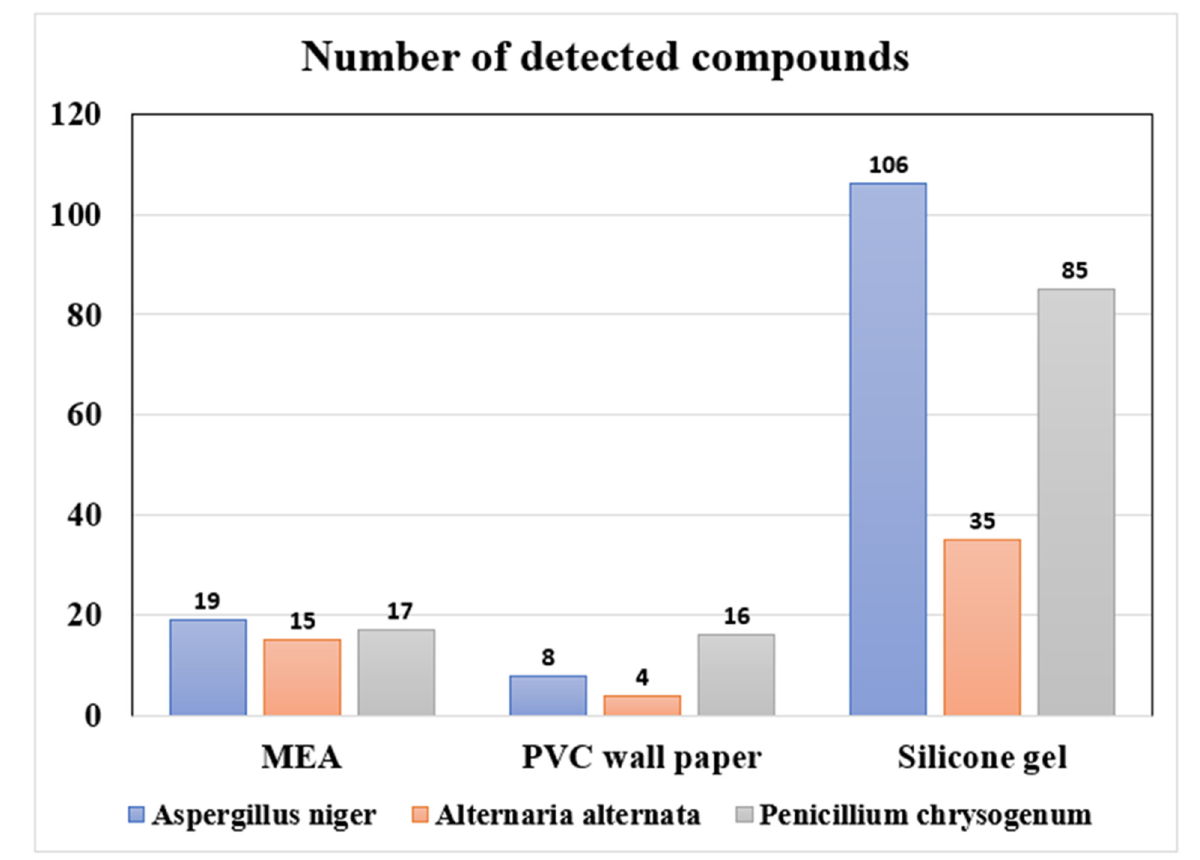
Figure 1. The number of compounds emitted from three fungi species cultivated on three different growth media. Table 1. Compounds detected from all three growth media (i.e., MEA, PVC wallpaper, and silicon rubber) for each